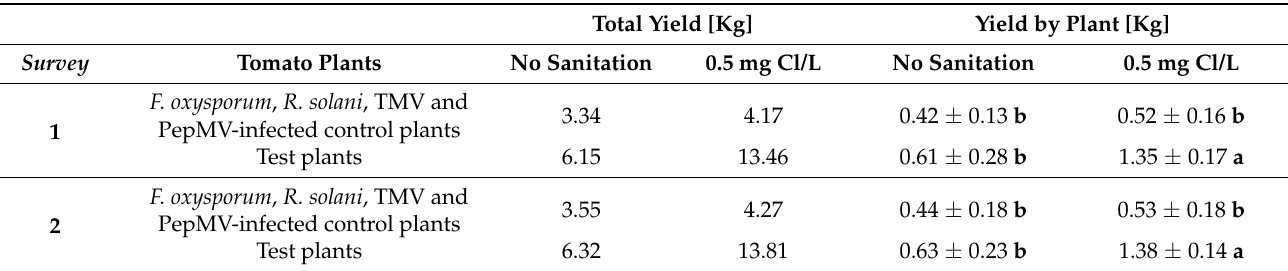
Figure 4. Box and whisker plot showing the maximum and minimum values (whiskers), the upper and lower quartiles (boxes) and the median (middle horizontal line) of the mean total yield of individual tomato plants during 10 harvest weeks dependent on a sanitizing treatment of the fertigation solution. Circles denote outliers beyond the whiskers. Significant differences are represented by different letters n = 18. Table 1. Total tomato yield of plants grown in an NFT hydroponic system with recirculating fertigation solution according to sanitizing treatment during a harvest period of 10 weeks. Mean values are shown for infected control plants (n = 8) and test plants (n = 10). Control: no sanitation, sanitation: 0.5 mg free chlorine/L for 60 min, weekly. Significance of comparisons calculated using Tukey-test, with values differing significantly from each other ( p < 0.05) being annotated by different letters (a, b). Values prefixed with ± represent the standard deviation.